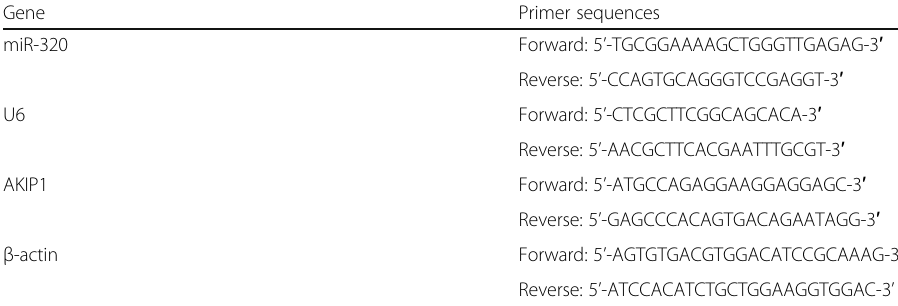
Table 1 Primer sequences of miR-320, U6, AKIP1 mRNA and β -actin Gene Primer